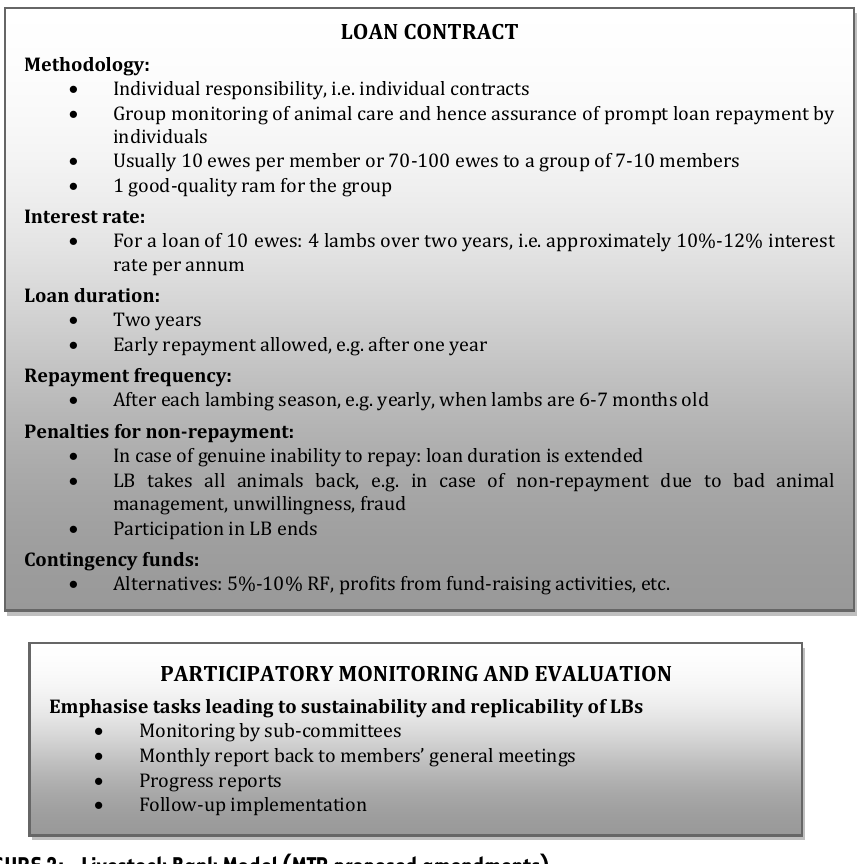
FIGURE 2: Livestock Bank Model (MTR proposed amendments) Source: